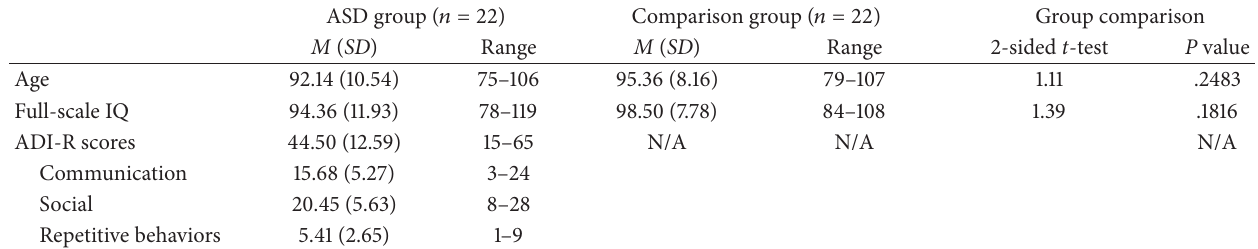
Table1: Demographiccharacteristicsofbothparticipantgroups: means( 𝑀 )andstandarddeviations( SD )forage(expressedinmonths),full- scale IQ, and ADI-R scores. Group differences in age or IQ were evaluated with independent samples 𝑡 -tests (homoscedasticity assumption checked with 𝐹